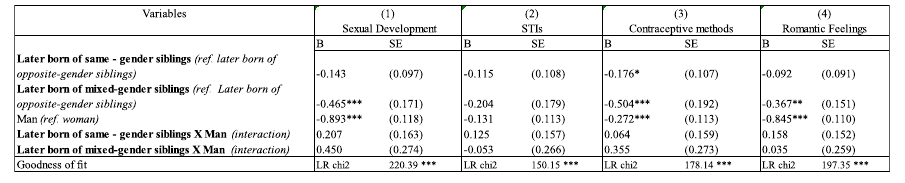
Table 3 Estimated coefficients of logistic regression models for the probability to have a deep communication with parents on sexual and romantic topics — later-born